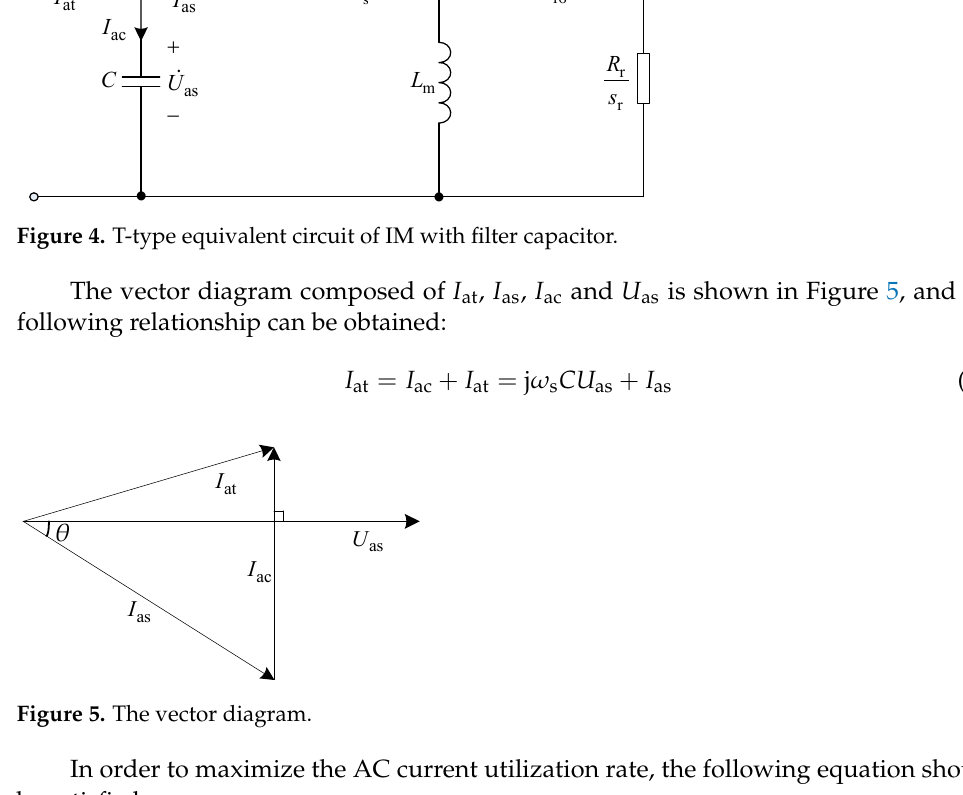
Table 1. The voltage of L dc and switching state in sectors II–VI.